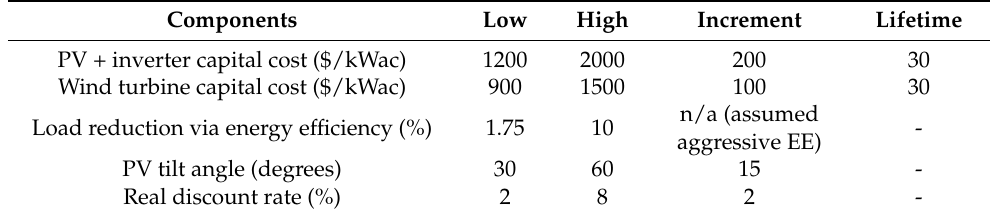
Table 5. A summary of sensitivity